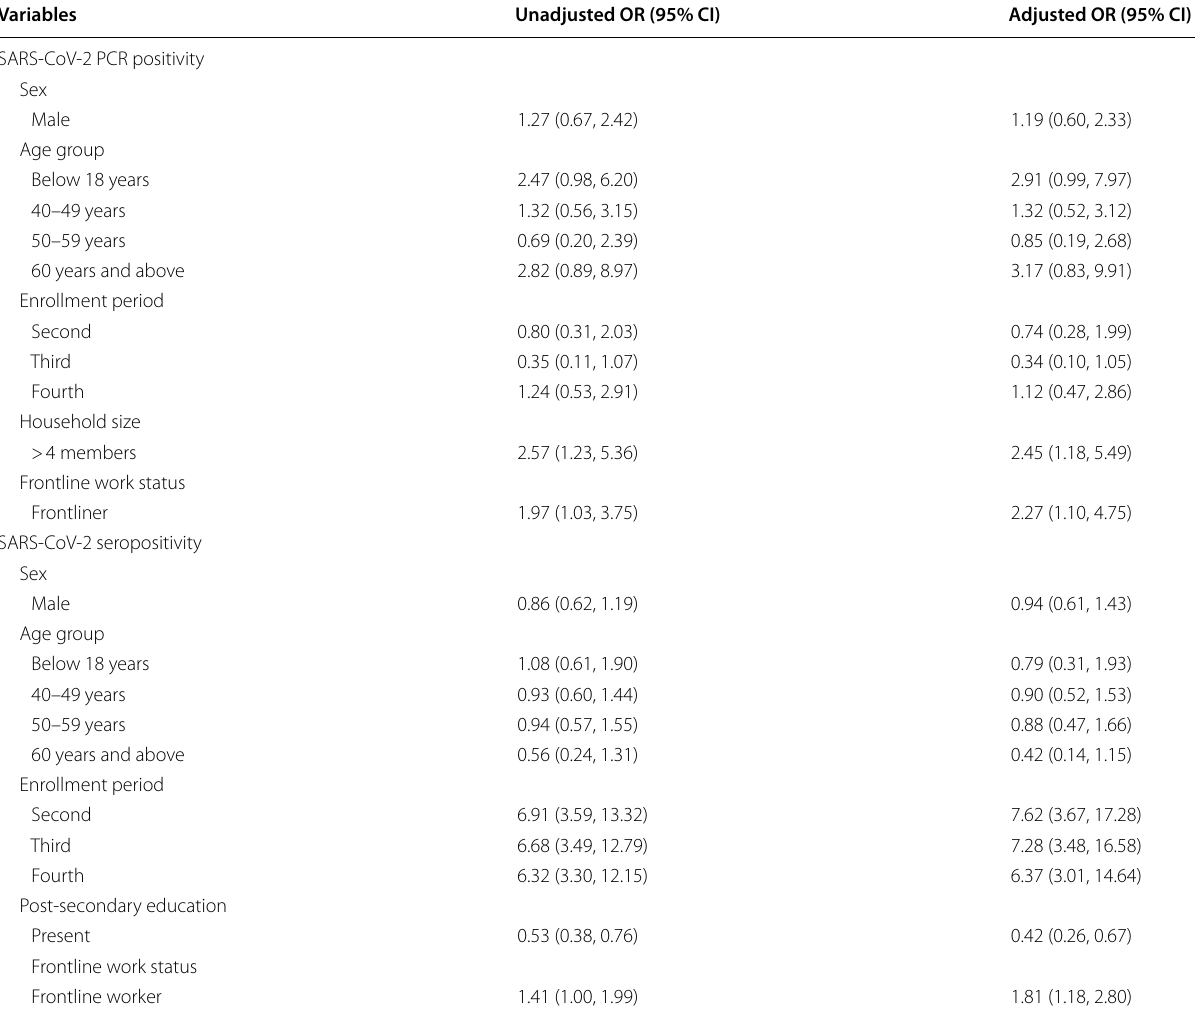
Table 4 Association between baseline characteristics and PCR Positivity and Seropositivity: final model